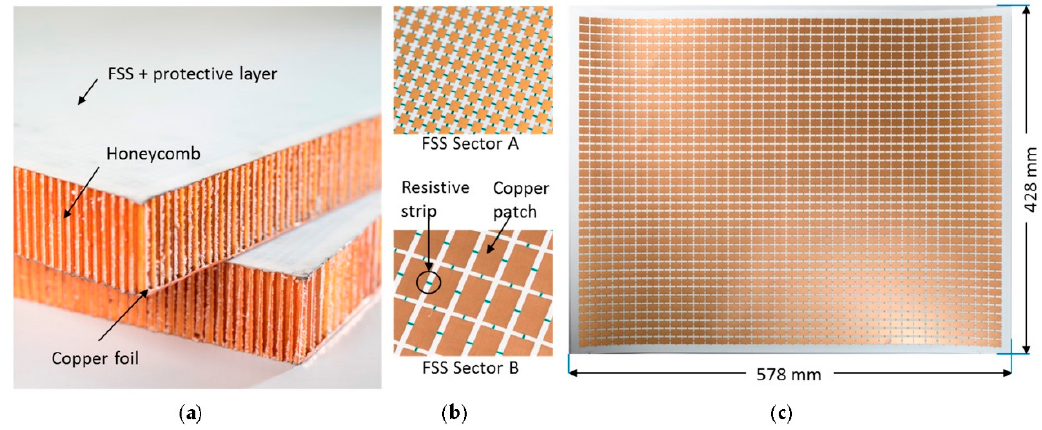
Figure 7. Pictures of the manufactured prototypes. ( a ) Two panels of sector A absorber. ( b ) FSS patterns of sector A and sector B. ( c ) Single panel dimensions.